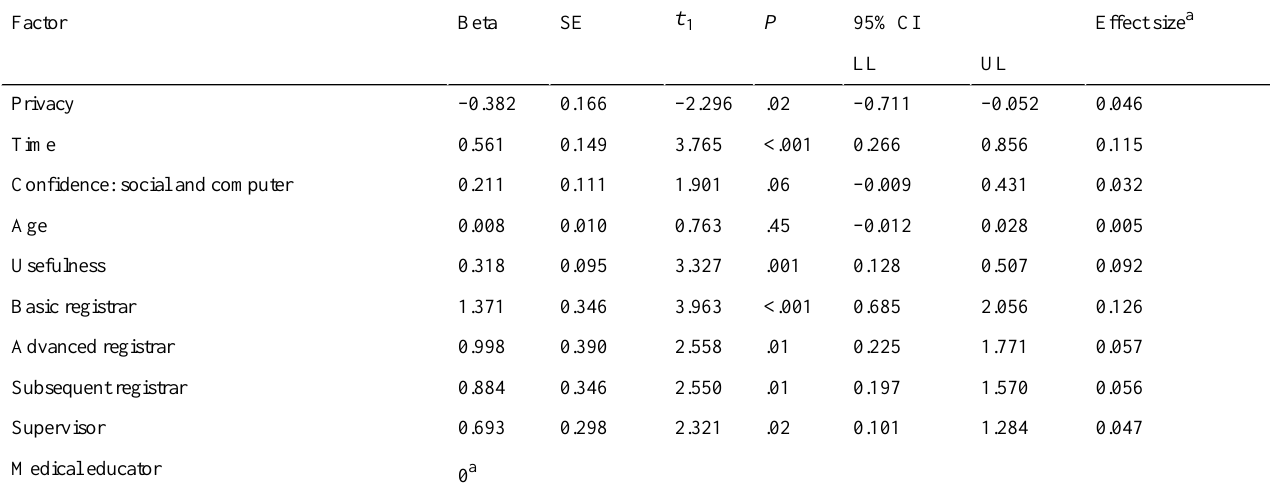
Table 7. Intention to use a private network for work